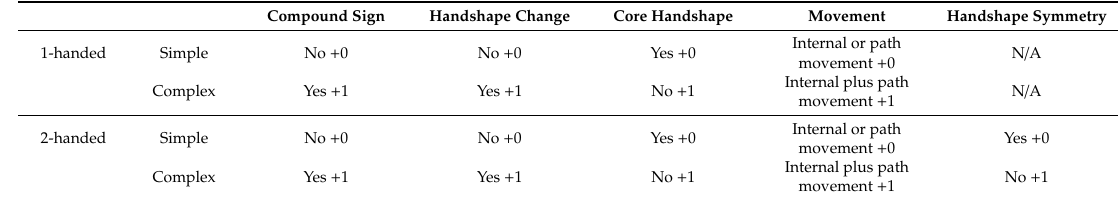
Table A2. Sign-copying task complexity rating scale.